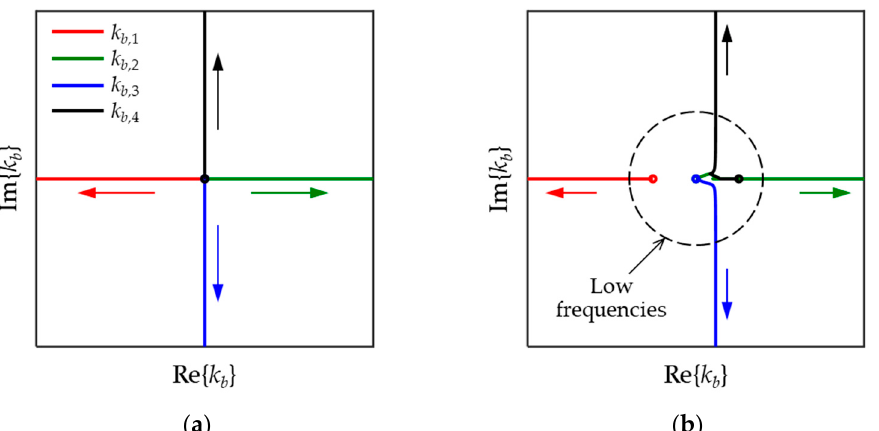
Figure 3. Wavenumbers for the fluid-conveying pipe with ( a ) U = 0 and ( b ) U = 60 (m/s) at increased excitation frequency .